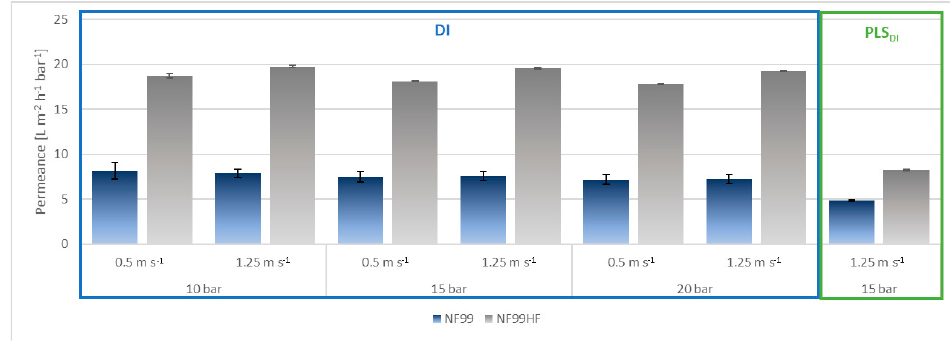
Figure 5. Average permeance for NF99 (blue) and NF99HF (grey) for DI and PLS DI as function of pressure and overflow velocity.